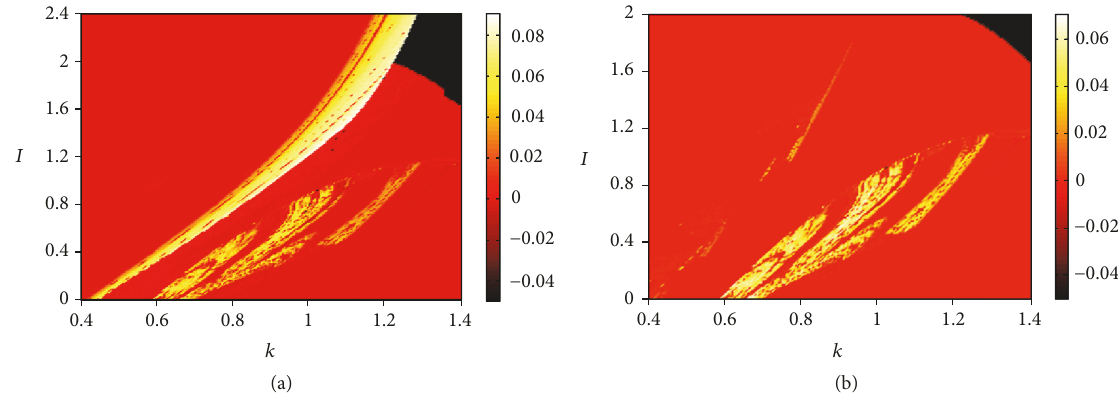
Figure 8: In the 𝑘 - 𝐼 parameter space, dynamical maps depicted by the largest Lyapunov exponent under different initial values. (a) Dynamical map for the initial values (0, 0, − 2). (b) Dynamical map for the initial values (0, 0,